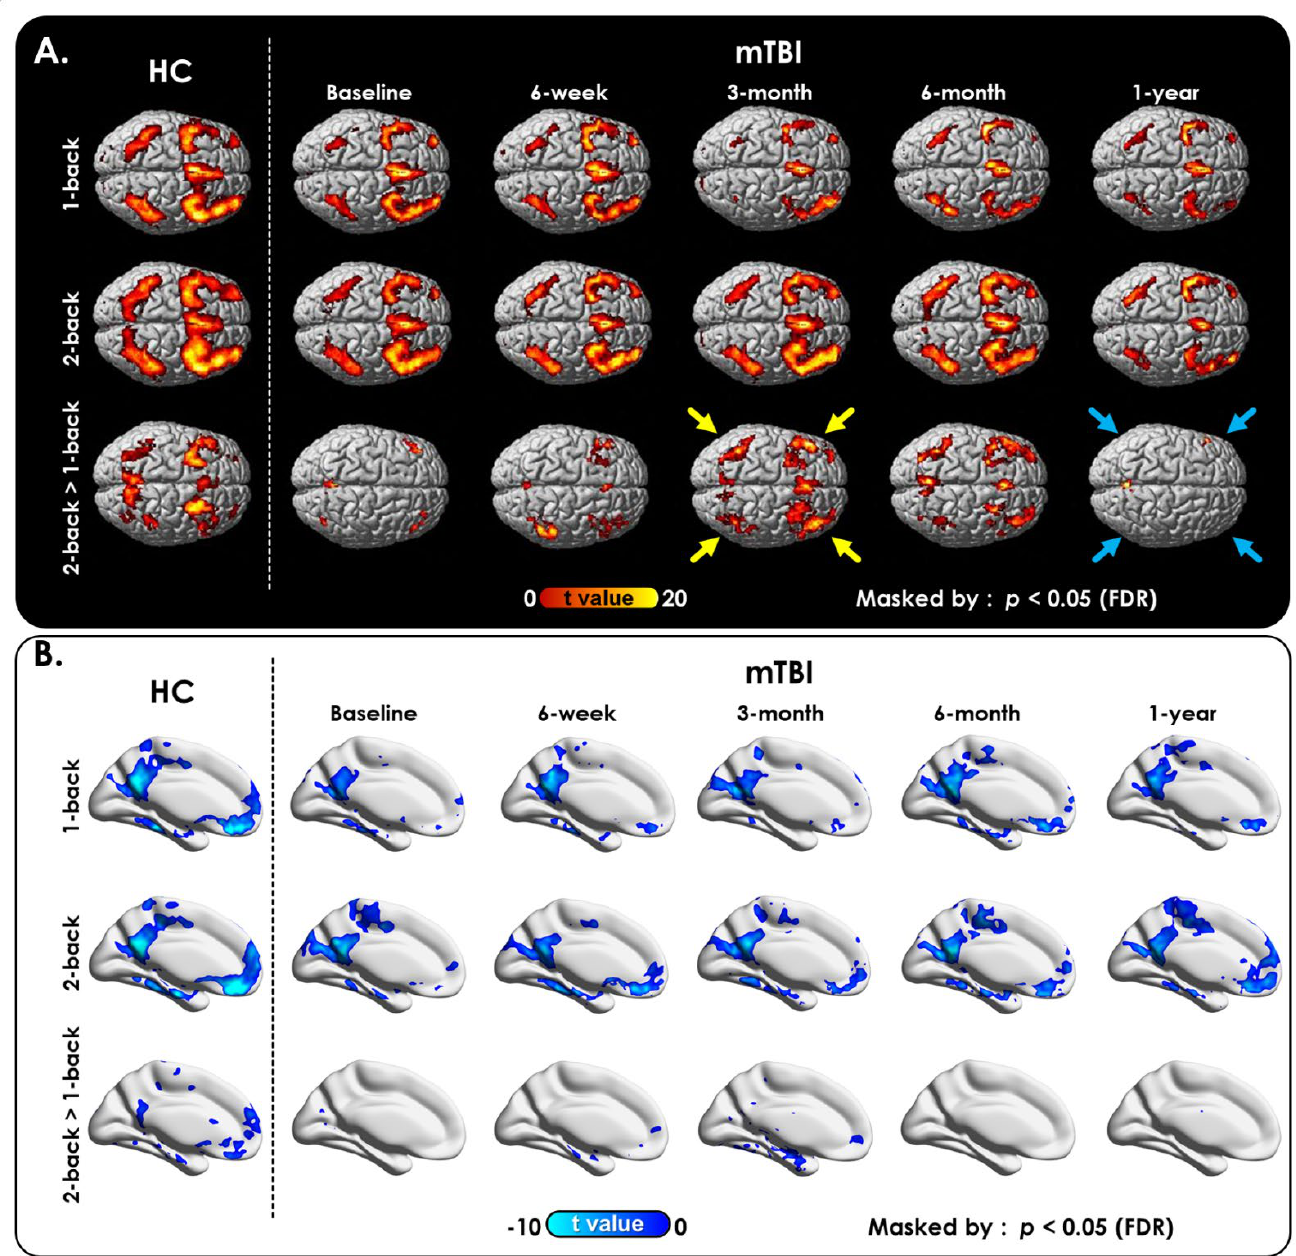
Figure 1. Postconcussive working memory activation and deactivation changes over time between baseline and follow-up. ( A ) Activation and ( B ) deactivation maps of 1-back, 2-back, and 2-back > 1-back WM conditions in HCs and patients with mTBI at each time point. Patients showed significant recovery under the WM 2-back > 1-back condition (bottom row) after 3 months (yellow arrows) but worsened again at the 1-year follow-up (blue arrows). Note that the statistical tests were corrected for multiple comparisons by controlling the false discovery rate (FDR) to q = 0.05 to avoid errors related to multiple comparisons in these calculations. Healthy Controls (HCs); mild Traumatic Brain Injury (mTBI).